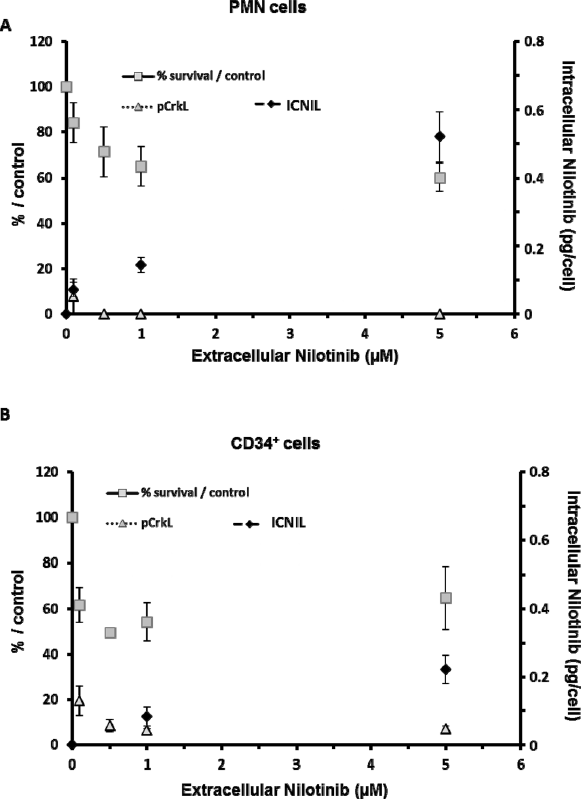
Figure 3. Relationship between intracellular nilotinib concentration and TKI efficiency in vitro. ( A ) The relationship between intracellular nilotinib (ICNIL; after 2 h of incubation) and nilotinib efficiency (i.e. inhibition of CrkL phosphorylation, pCrkL, and cell survival at 30 h of incubation) was evaluated in mature CD15 + CD34 - (PNM) and ( B ) immature CD15 - CD34 + cells (n = 3) after incubation with the indicated concentrations of nilotinib (extracellular nilotinib). Results are the mean ± standard